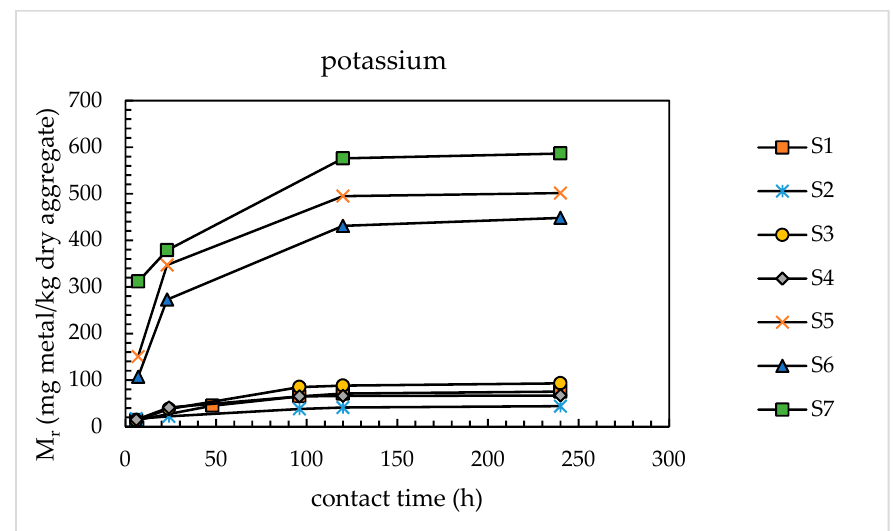
Figure 6. Effect of contact time on potassium release from sands S1–S7.